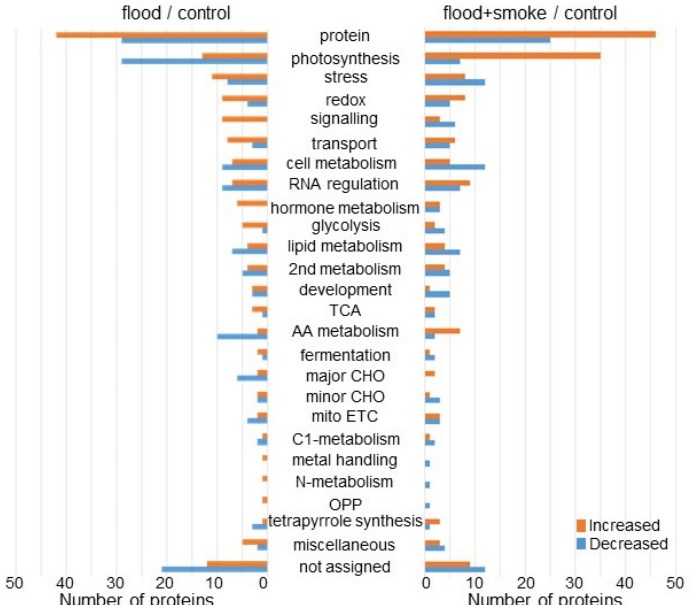
Figure 4. The functional categories of proteins with differential abundance in wheat treated with the plant-derived smoke solution under flooding stress. Wheat seeds were sown and treated with or without the plant-derived smoke solution. Three-day-old wheats were exposed with or without flooding. After proteomic analysis, the functional categories of the significantly changed proteins ( p < 0.05) from wheat treated with and without the plant-derived smoke solution under flooding were determined using MapMan bin codes (Tables S2 and S3). Red and blue columns show the number of increased and decreased proteins, respectively. Abbreviations: AA, amino acids; mitoETC, mitochondrial electron transport chain; OPP, oxidative pentose phosphate; and TCA, tricarboxylic acid cycle; “not assigned” indicates proteins without ontology or characterized functions.